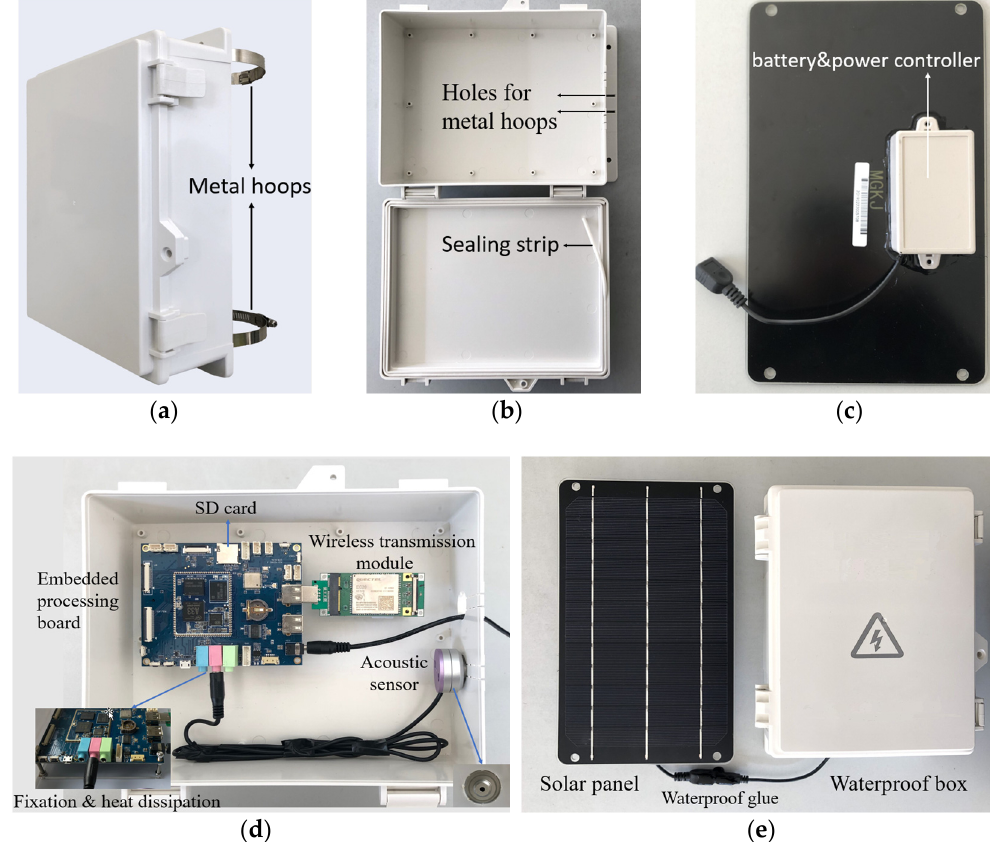
Figure 5. The structure of a sensor node. ( a ) External appearance of the waterproof box; ( b ) interior view of the waterproof box; ( c ) the solar panel with a battery and power controller inside; ( d ) the connection of different parts inside the box; ( e ) a whole sensor node.